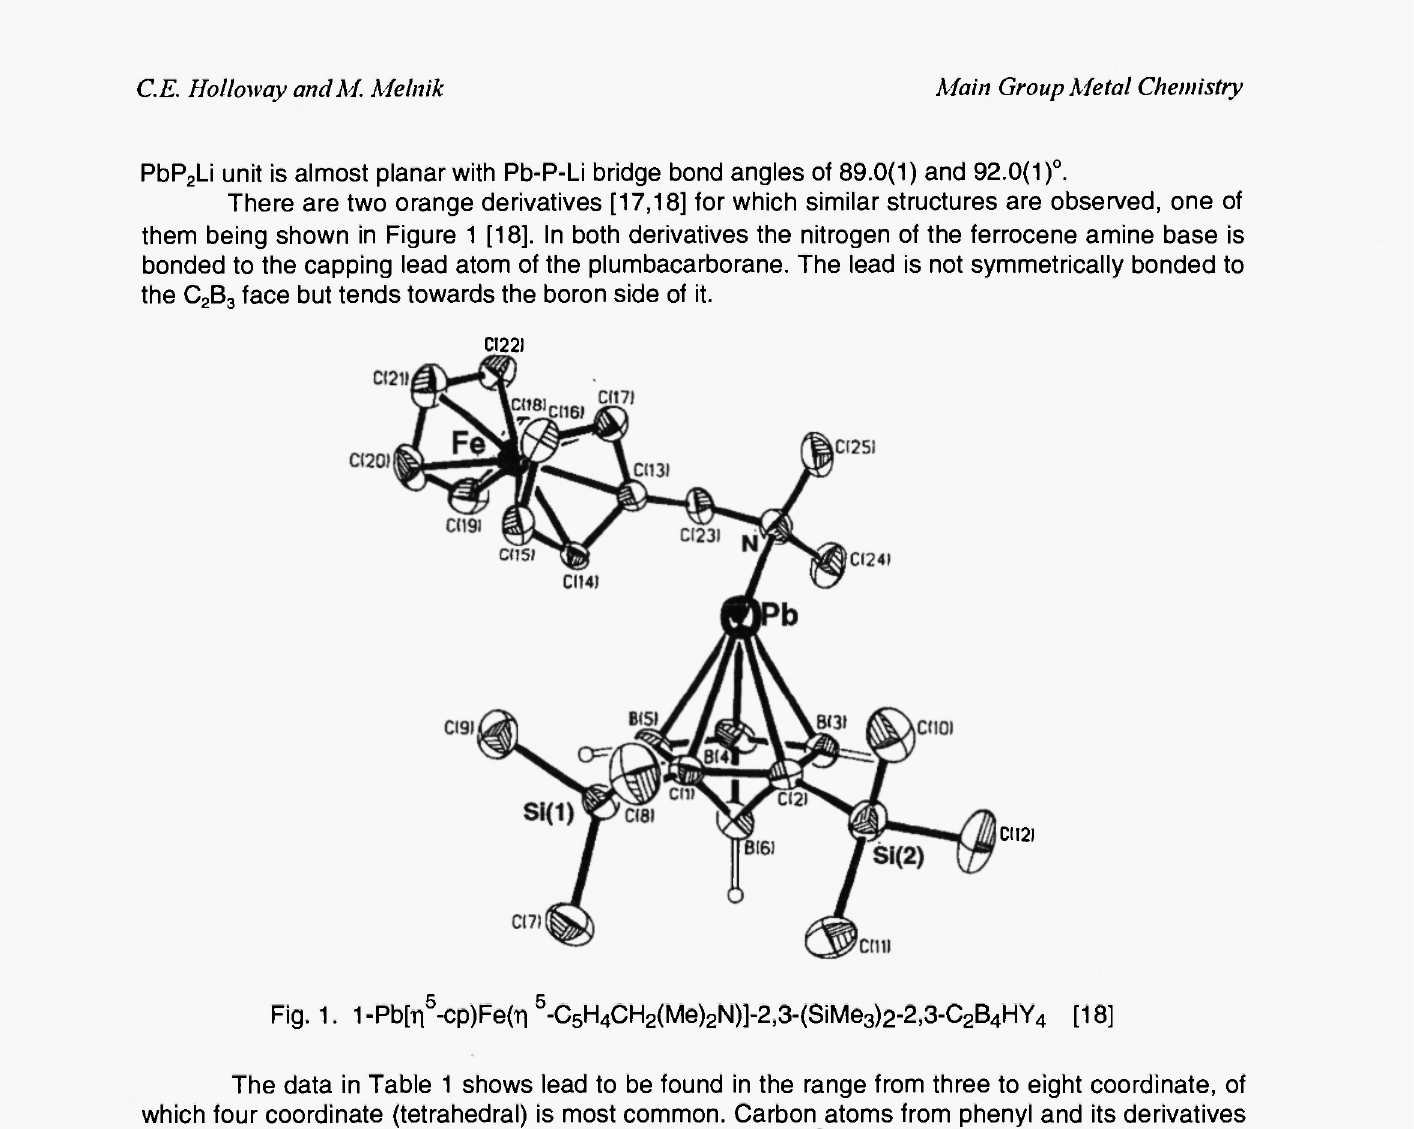
Fig. 1. 1 -Pb[Ti 5 -cp)Fefr 5 -C 5 H4CH2(Me) 2 N)]-2,3-(SiMe3)2-2,3-C2B4HY 4